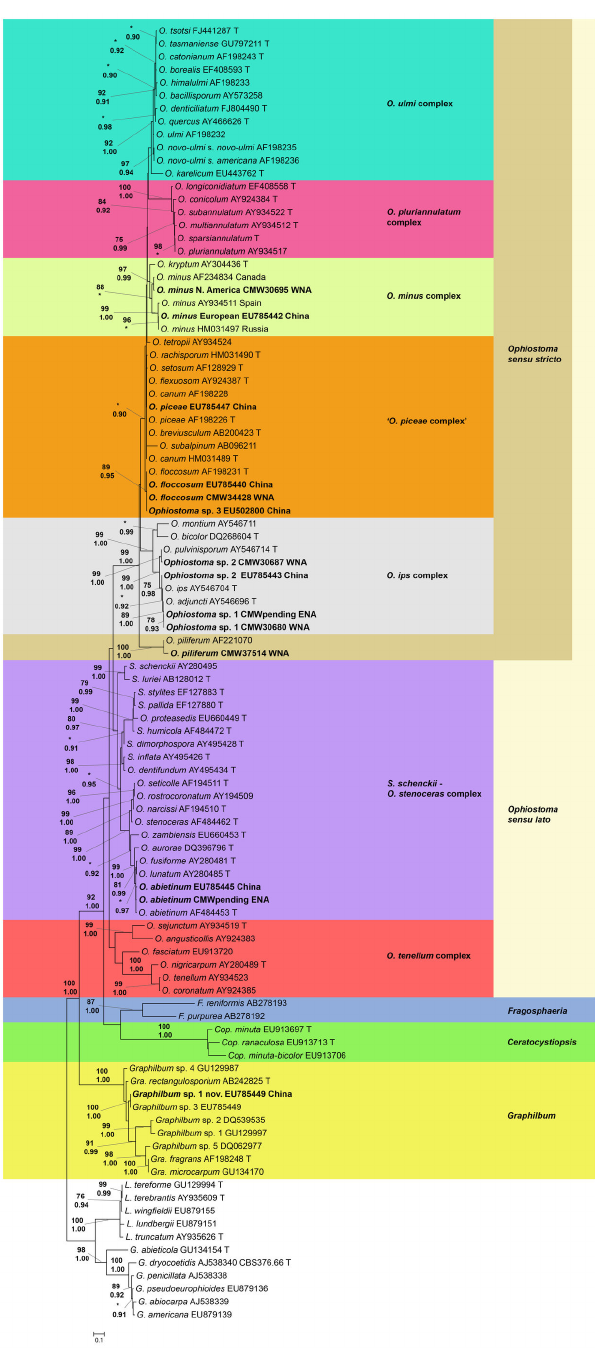
Figure 2. Phylogram of Ophiostoma sensu lato based on ITS1-ITS2. Maximum likelihood (ML) phylogram of 75 ophiostomatalean fungi in the genus Ophiostoma sensu lato , two in the genus Fragosphaeria , three in the genus Ceratocystiopsis , nine in the genus Graphilbum , and 11 in the genus Leptographium sensu lato as an outgroup, based on ITS1-ITS2. Each strain is indicated by its species name, the Genbank accession number or CMW culture collection number (if accession number is not available), and a T if the isolate originates from a species’ type specimen. Strains associated with D. valens either from this study or the Chinese studies [54,55] are in bold font, and are followed with the location they were isolated from. Strains are subdivided into species complexes indicated by different colors. Statistical support is given to the left of the nodes, with ML bootstrap proportions on top (only values greater than 75 are shown), and Bayesian posterior probability (PP) values on the bottom (only values greater than 0.90 are shown). * indicates that the ML or PP values were not significant at those nodes. doi: 10.1371/journal.pone.0078126.g002 PLOS ONE |